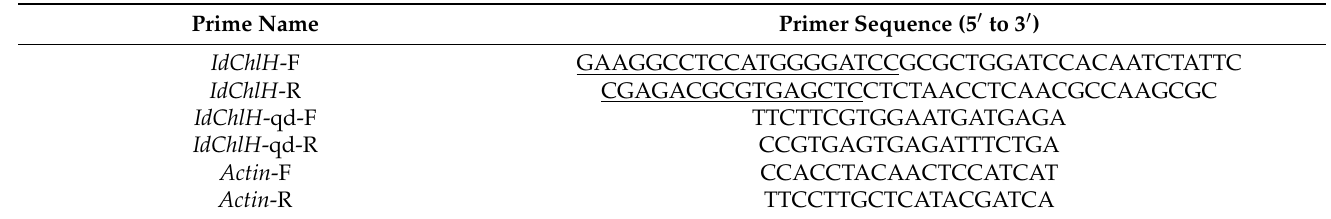
Table 1. List of primers used in this